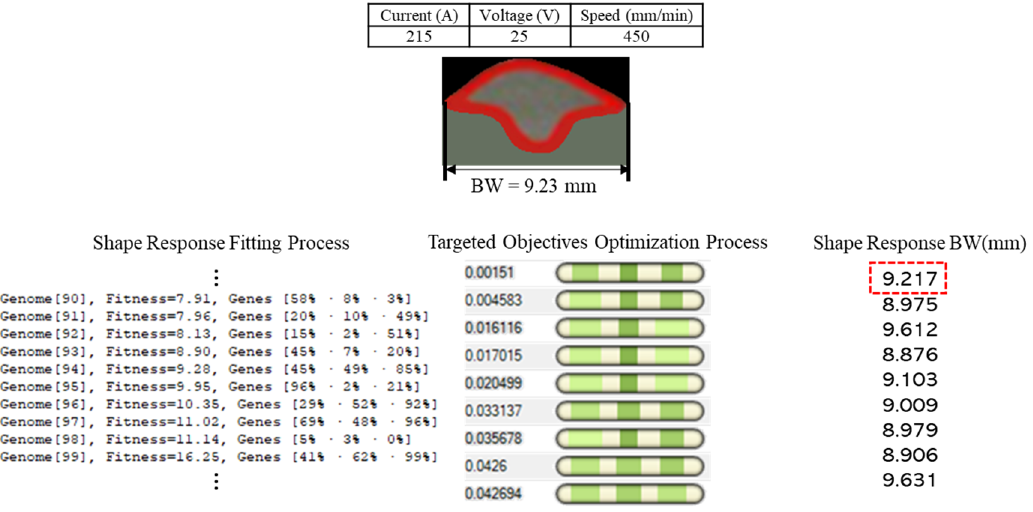
Figure 14. Bead width prediction process with experimental validation.